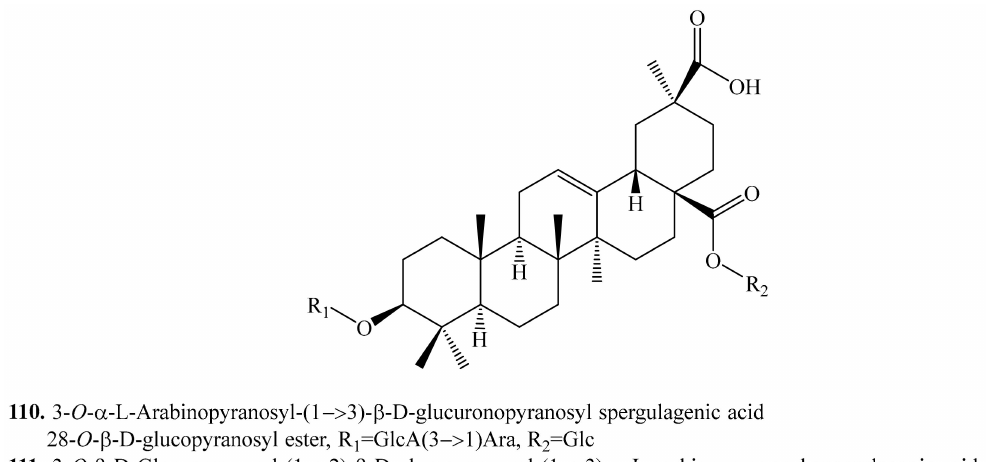
Figure 13. Structures of the spergulagenic acid glycosides isolated from quinoa.